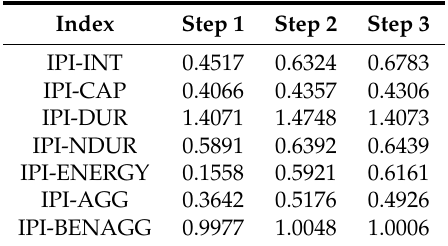
Table 24. Comparison of mean ratio between RMSEs with an expanding window from 2015:01 to 2018:12.